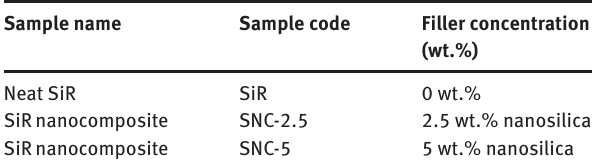
Table 1: Prepared SiR composite samples.